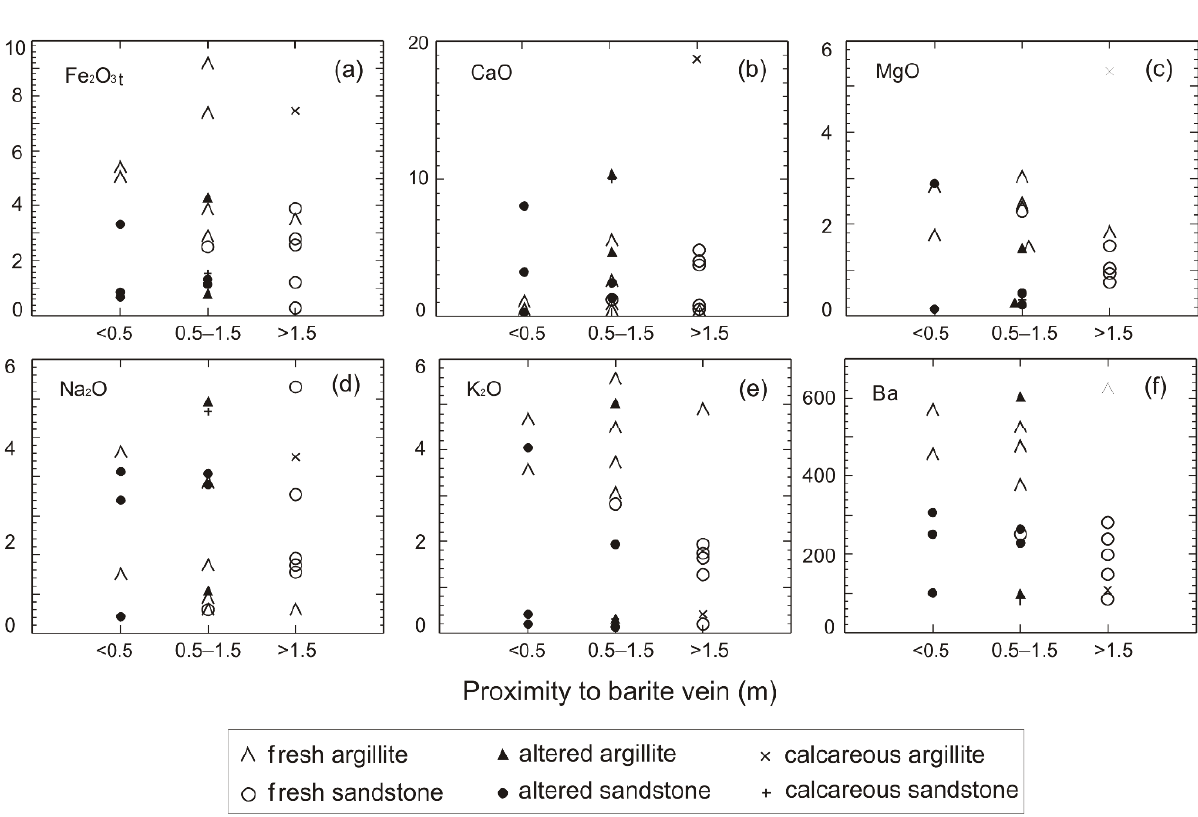
Figure 11. Geochemical composition of Horton Group host rocks compared with distance from barite veins, from the area north of Five Islands (localities 9–15). ( a – f ) show plots for different elements.